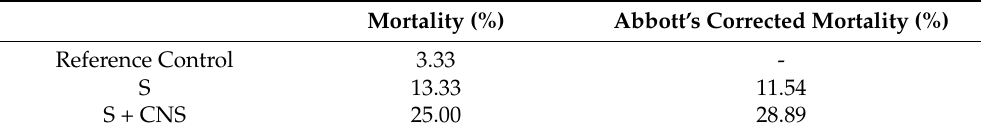
Table 3. Heterocypris incongruens bioassay test. Percentage of mortality and Abbott’s corrected mortality recorded.